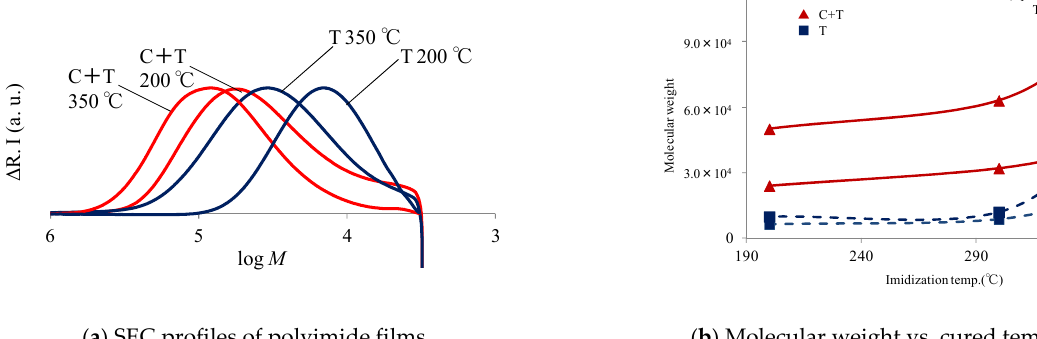
Figure 4. ( a ) SEC profiles of polyimide films prepared from CpODA and 3,4 ′ -DDE using a thermal (“T”) and a combined chemical and thermal (“C + T”) methods at each 200 °C or 350 °C cure; ( b ) The number-averaged (Mn) and the weight- averaged (Mn) molecular weights plotted as a function of the cured temperatures, where blue dashed lines and red solid lines denote the polyimides prepared by “T” and “C + T” methods, respectively.